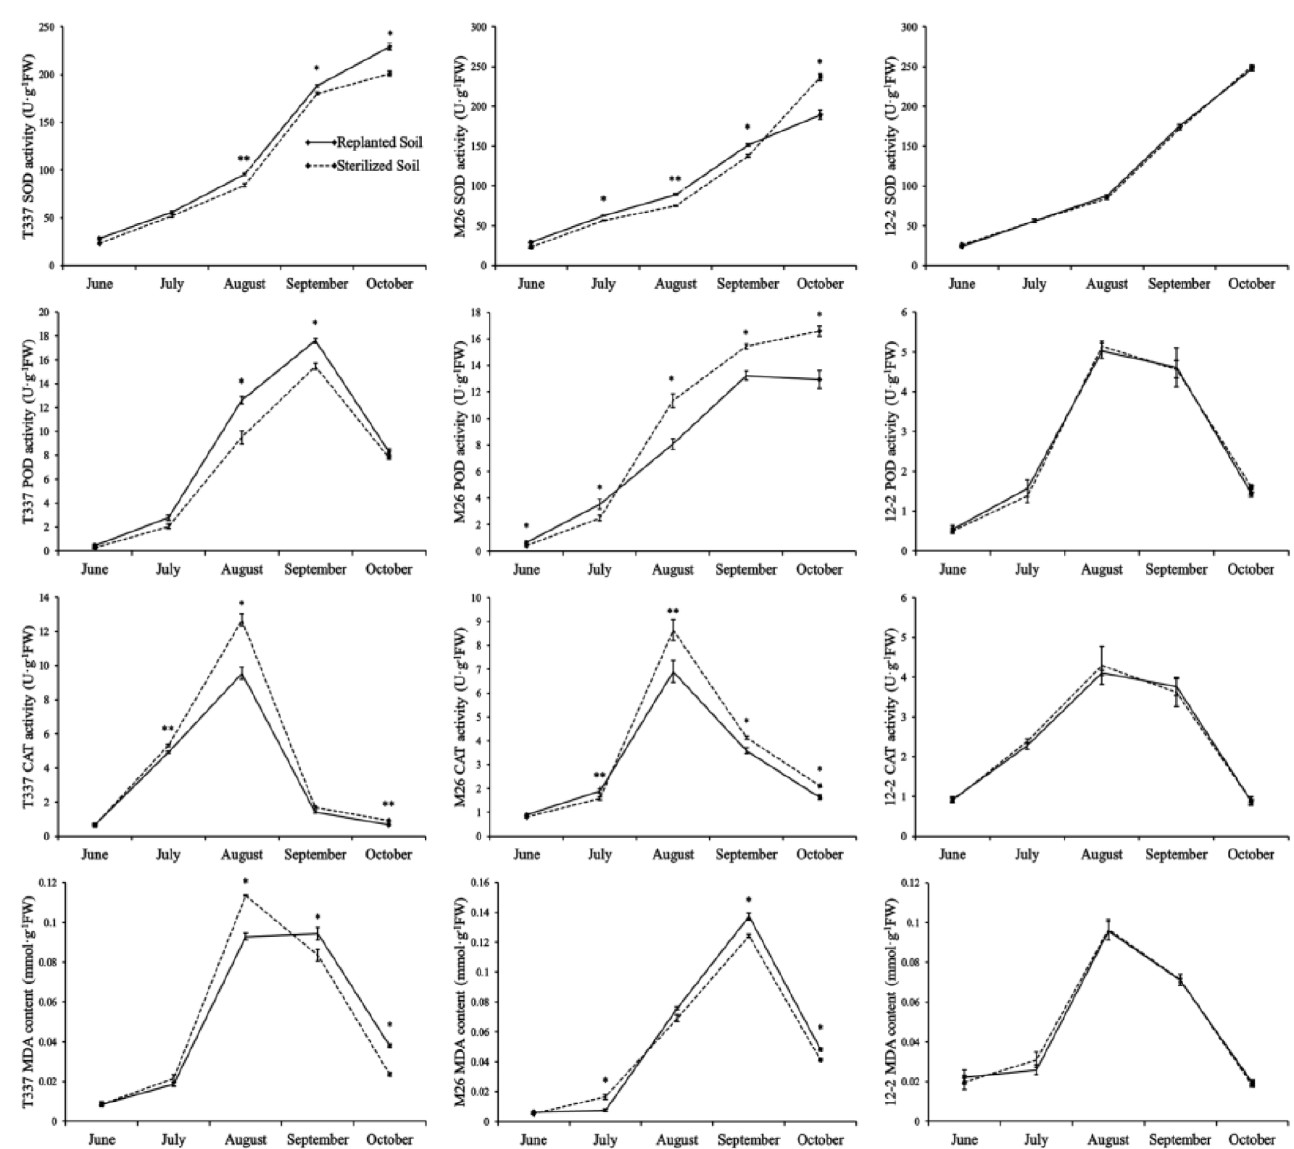
Figure 5. The antioxidant enzyme activities and the malondialdehyde content in leaves of plants with different rootstock types planted in sterilized and replanted soil.